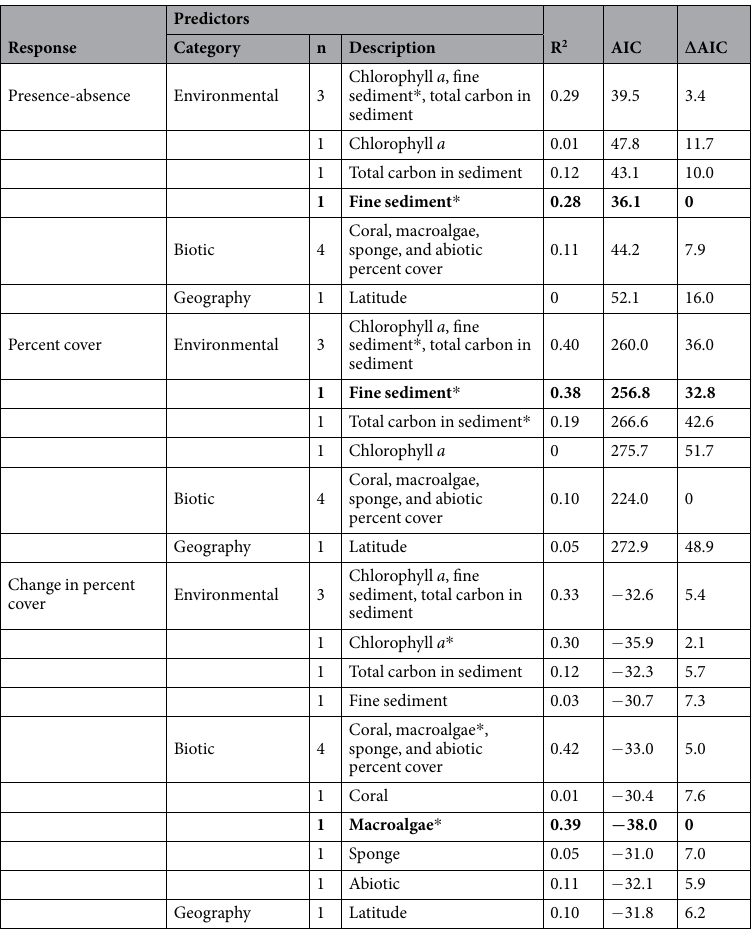
Table 1. Environmental variables are stronger predictors of Cliona orientalis distribution and abundance than biotic variables. The table contains a comparison of models with three categories of predictors, representing the hypotheses that the C . orientalis response was influenced by the percent cover of other taxa, environmental conditions, or latitude. The table includes the C . orientalis response variable; the category, number and description of predictors; the proportion of deviance explained by the predictors (R 2 ); and the Aikaike Information criterion score (AIC). An * indicates predictors which were statistically significant and statistics are reported in figure legends. The most parsimonious model, in terms of R 2 and AIC, is indicated in